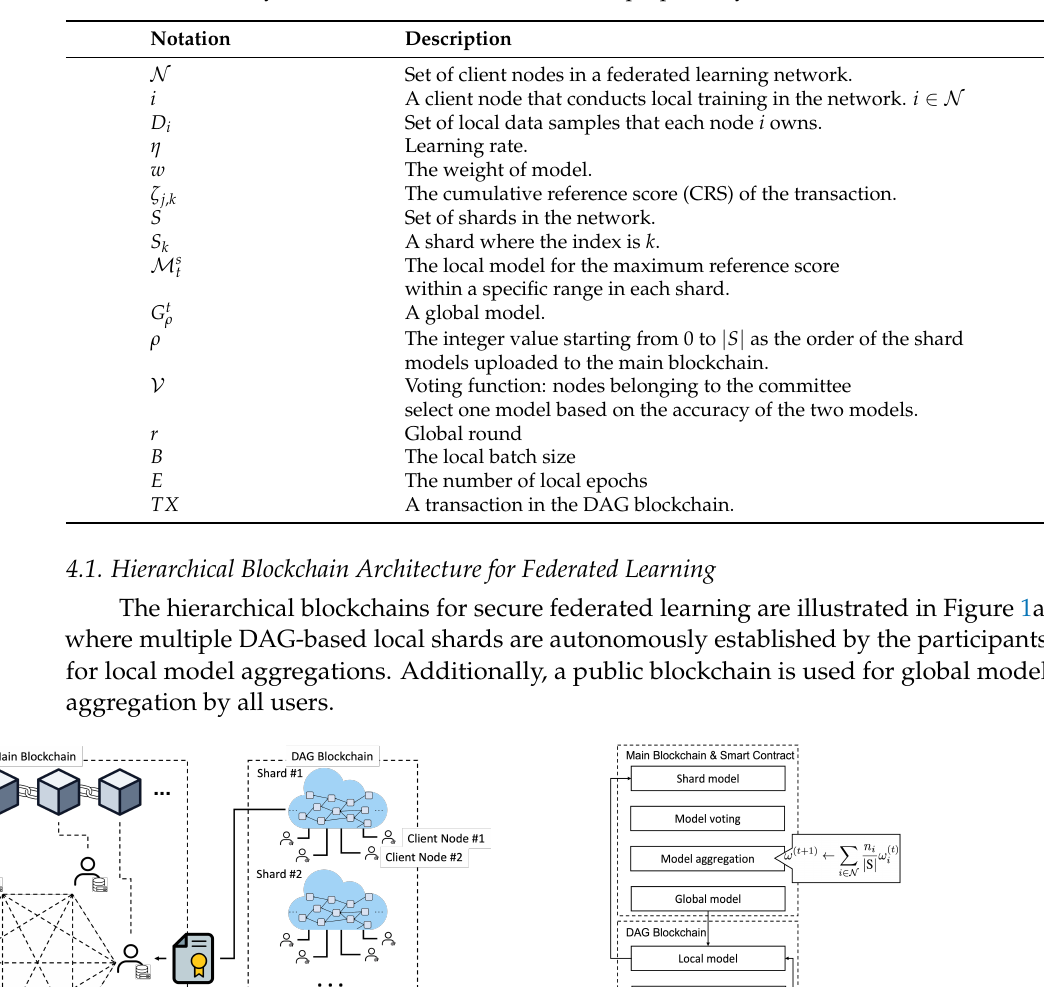
Table 1. The list of symbols that are used to describe the proposed system.